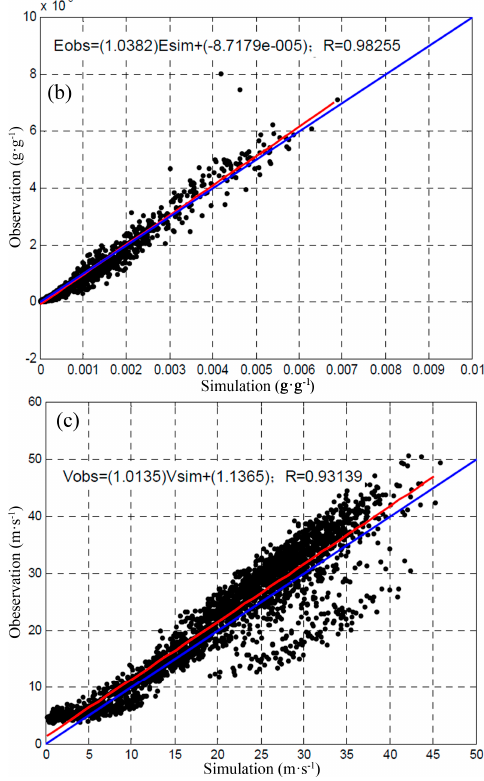
Figure 4. Temperature scatter diagram ( a ); specific humidity ( b ); and wind speed ( c ) (The red line is fitted line, and the blue line is 1:1 diagonal line).